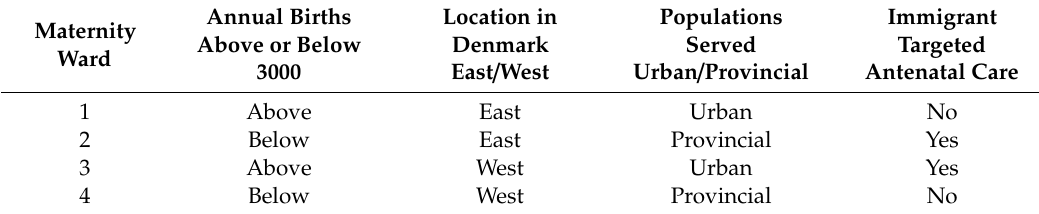
Table 1. Data collection